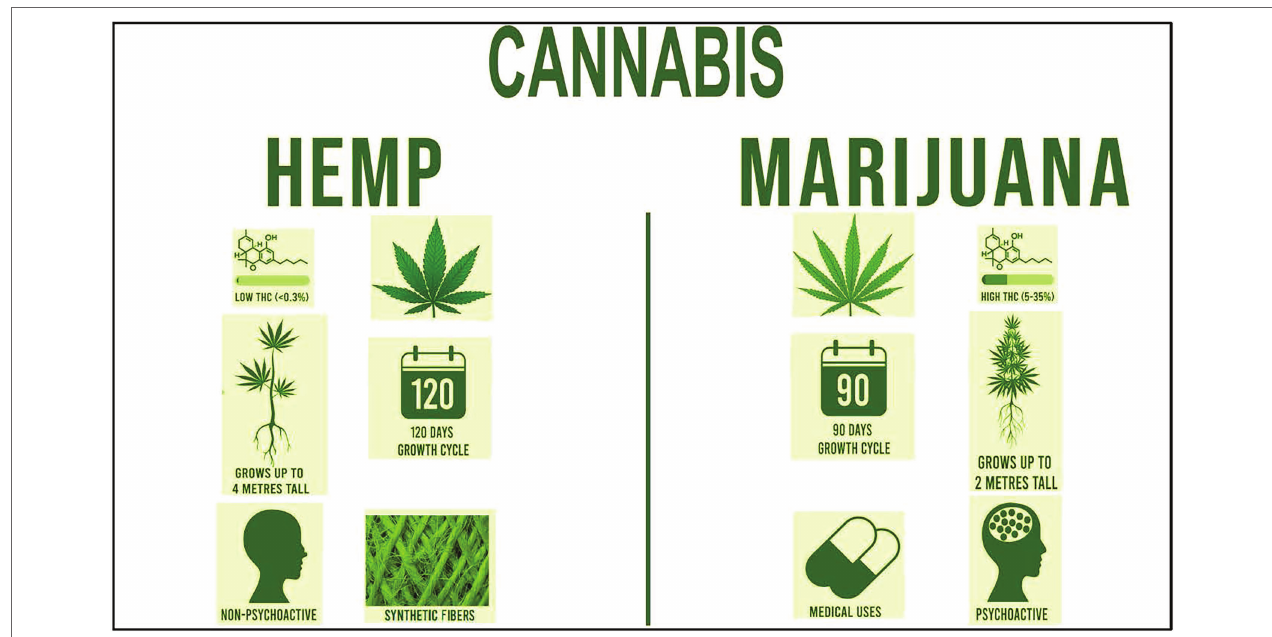
FIGURE 1 | Comparison of the two varieties of Cannabis: industrial hemp and marijuana. The general leaf structure, percent levels of THC, psychoactive properties, growth height, growth cycle days, and uses are